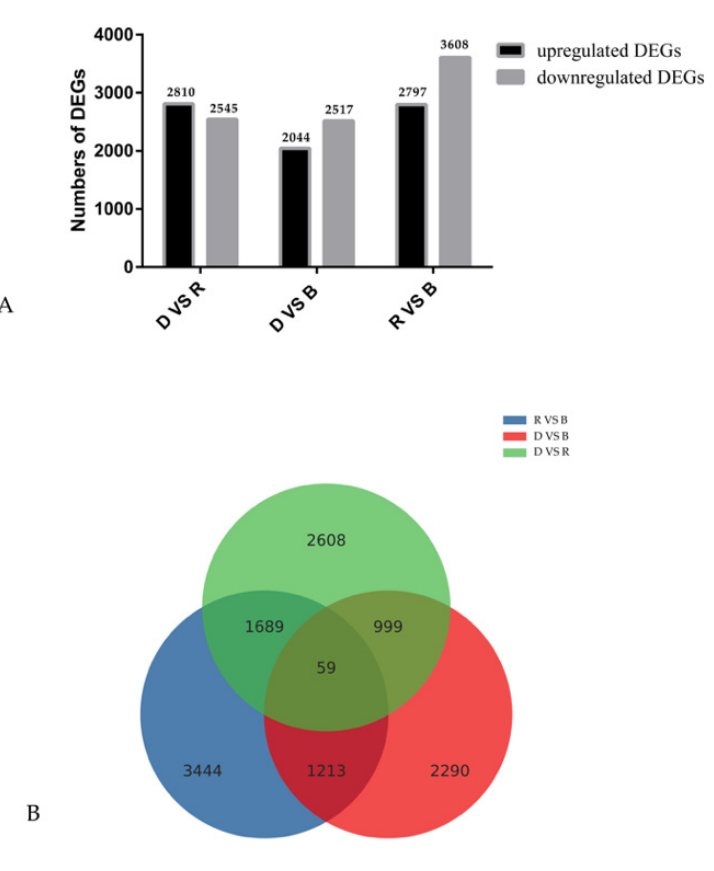
Figure 3. Gene expression comparisons. ( A ). The gene expression profile of DEGs. ( B ). Venn diagram of the number of differentially expressed genes (DEGs). The numbers of upregulated and downregulated genes between D vs. B, D vs. R, and R vs. B are shown.